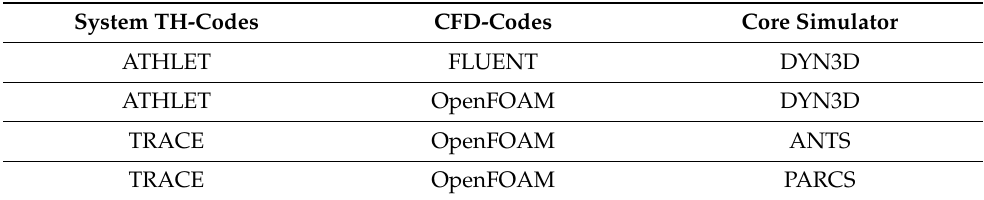
Table 1. Numerical tools for the plant analysis of NuScale and